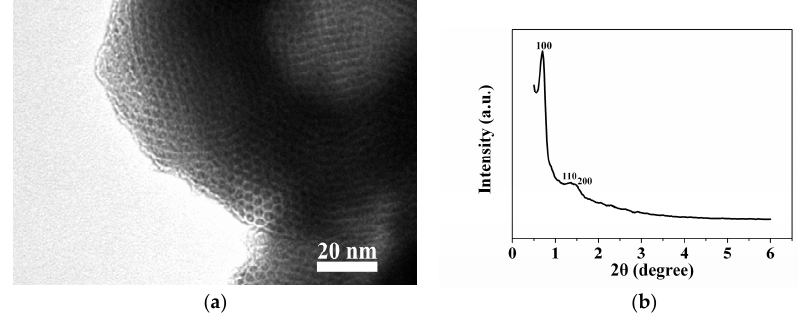
Figure 2. Transmission electron microscope (TEM) image ( a ) and X-ray pattern ( b ) of the silica matrix containing both enzymes. containing both